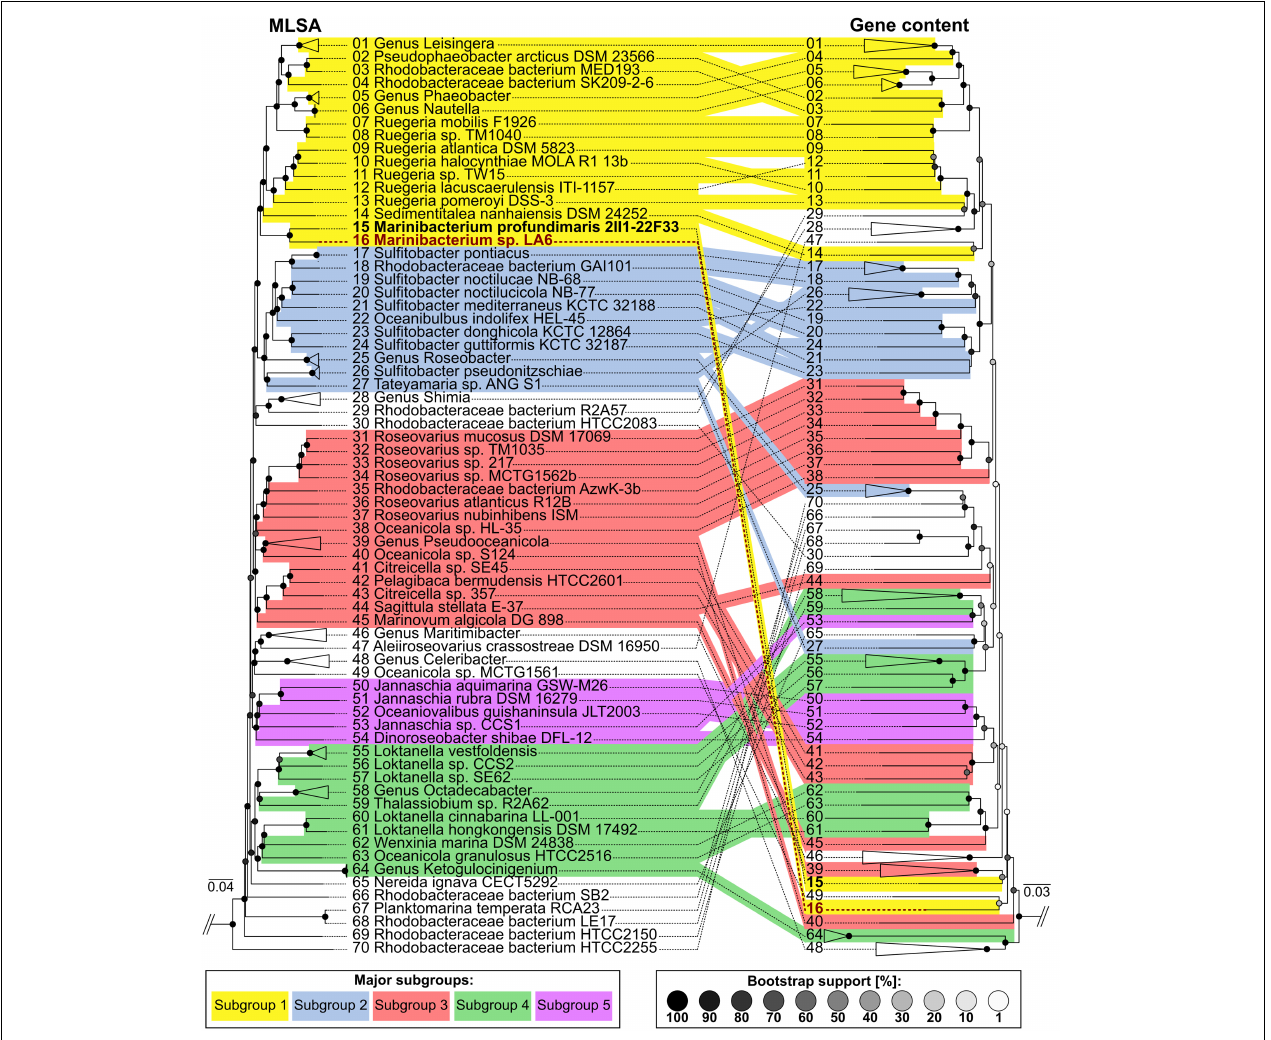
FIGURE 6 | Clustering of Roseobacter group genomes showing the relationships between sequenced strains based on multilocus sequence analyses (MLSA) as well as gene content. MLSA (left) is based on concatenated aligned core-genome gene product sequences and illustrates phylogenetic relationships with high resolution and confidence. Coherent clusters corresponding to the five subgroups originally described by Newton et al. (2010) are marked in color. Corresponding branches between the MLSA and gene content tree are indicated by identical numbering. For ease of viewing, genera and species consisting of multiple genomes which cluster coherently in the MLSA as well as the gene content tree are shown collapsed. Furthermore, the outgroup ( Parvularcula bermudensis HTCC2503) is not shown. In contrast, gene content clustering (right) is based on the presence and absence of orthologs shared between the comparison genomes. This illustrates similarities and differences in gene composition between genomes, thereby reflecting adaptations to individual niches and lifestyles. Divergences between MLSA- and gene content-based clustering show that even closely related strains may possess strongly diverging gene